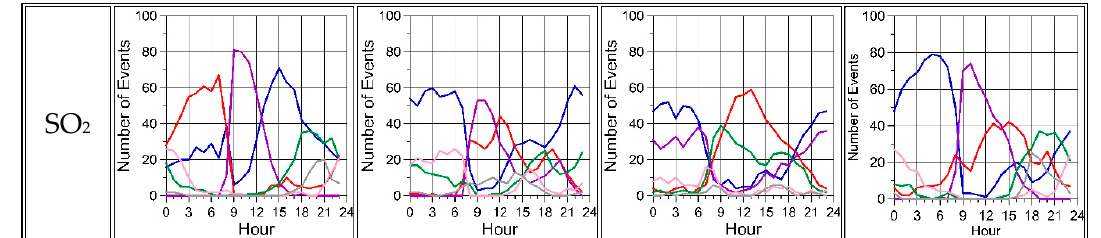
Figure 7. Application of the k-means algorithm (with k = 6) to the seasonal subsets of the data objects of the wind circulation (first row) and pollutant-flows (next four rows) events. Each graph shows six plots, one per cluster, individualized by the color. Each plot expresses the hourly population of the cluster , i.e., the number of data objects (or events) of the cluster as a function of the hour of the day. For wind circulation or any given pollutant-flow, a qualitative comparison of graphs in the respective row allowed recognizing some seasonal similarities and differences between the clusters.